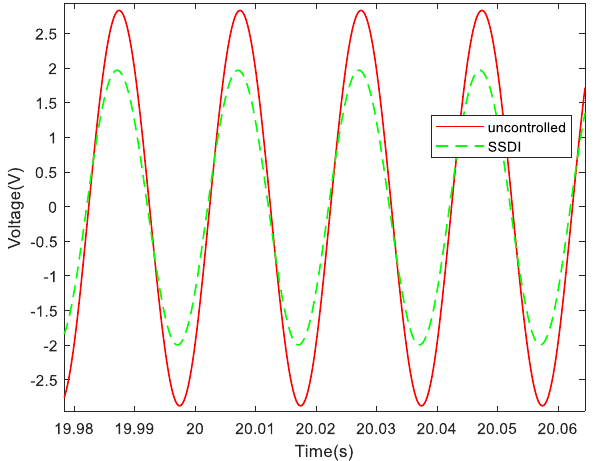
Figure 22. Displacement comparison curves in the time domain with and without an SSDI (50 Hz).